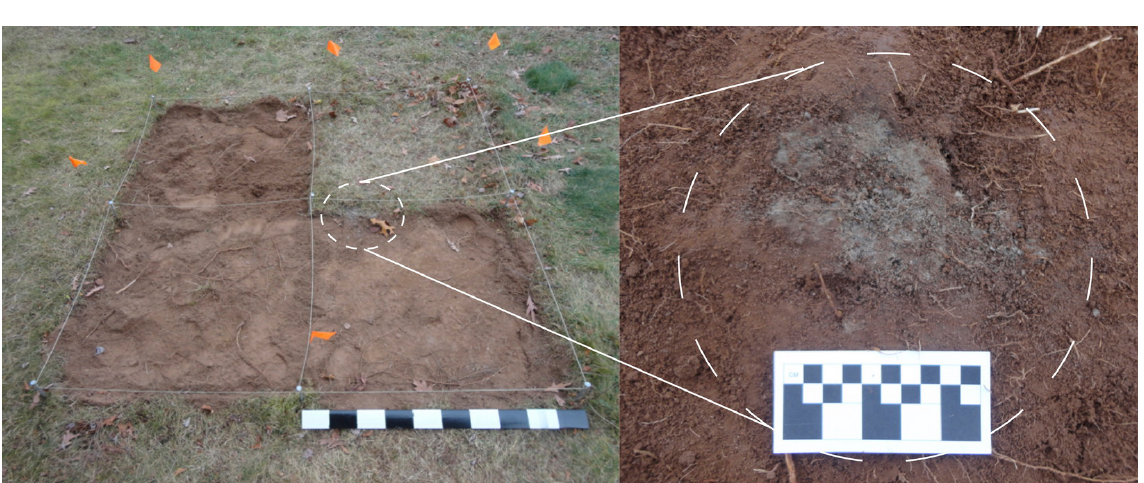
Figure 4. (L) The 2x2 meter grid partially excavated with an emphasis on the slurry lens (white dotted-line). (R) Close-up of the impaction-slurry lens below the sod layer. The dimensions of the lens in the sod layer were 37cm